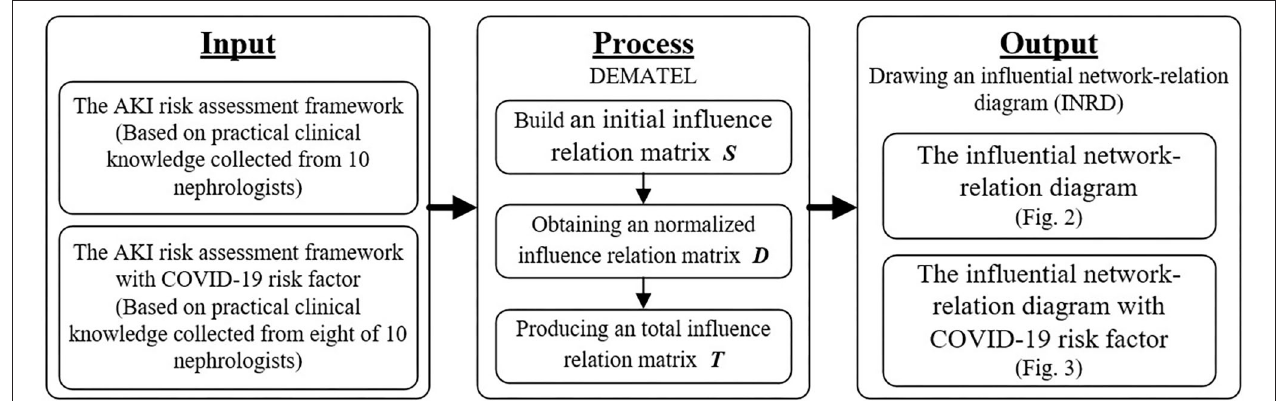
FIGURE 1 | The research flow chart.